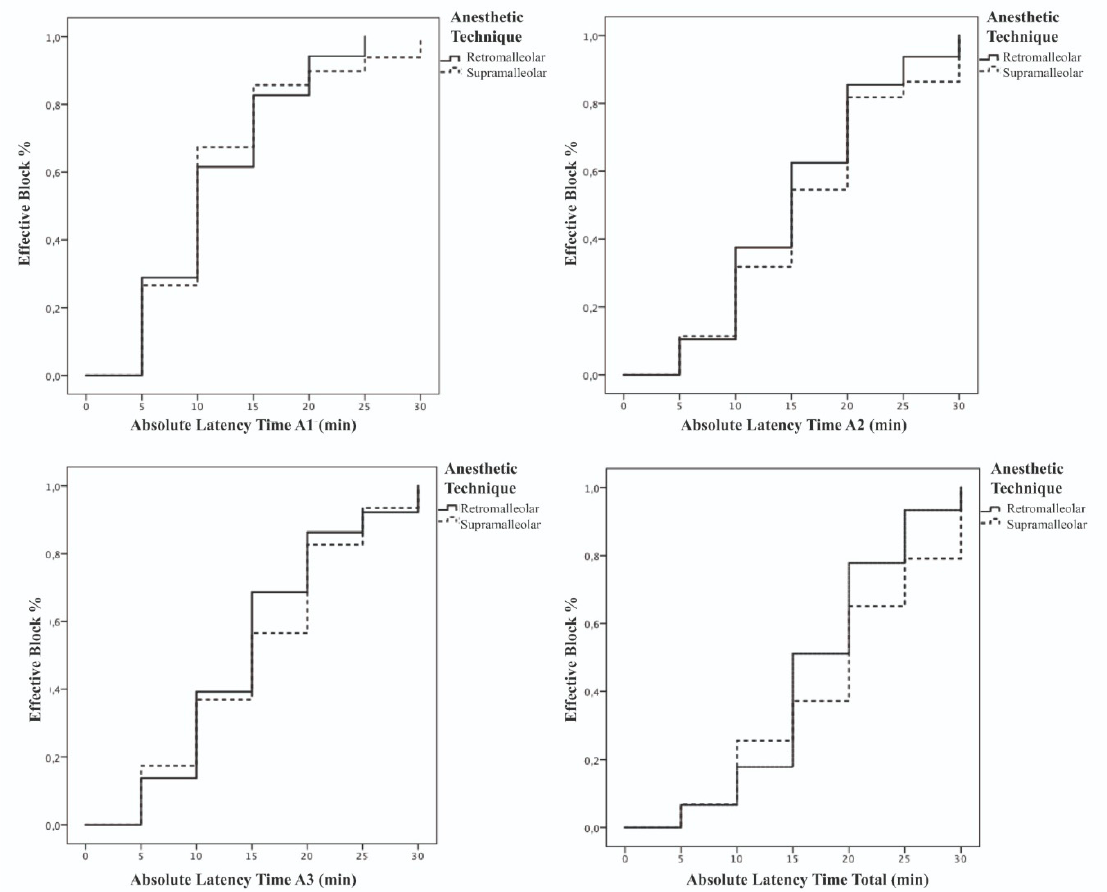
Figure 6. Comparison of the percentage of effective blocks based on the latency time for each of the areas and anesthetic techniques.